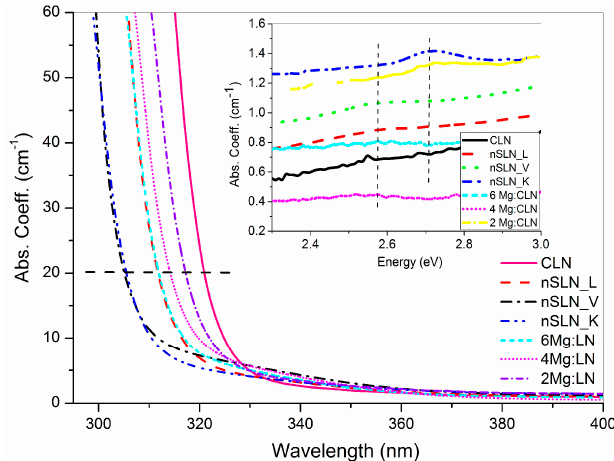
Figure 7. Absorption spectra of CLN, Mg doped CLN and nSLN crystals. Inset shows absorption band due to bi-polaron absorption at around 2.55 eV. due to bi-polaron absorption at around 2.55